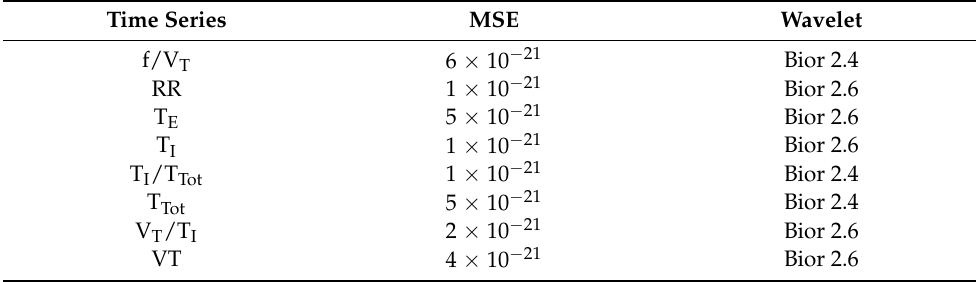
Table 1. Mean squared error (MSE) of the best wavelets for each time series. Time Series